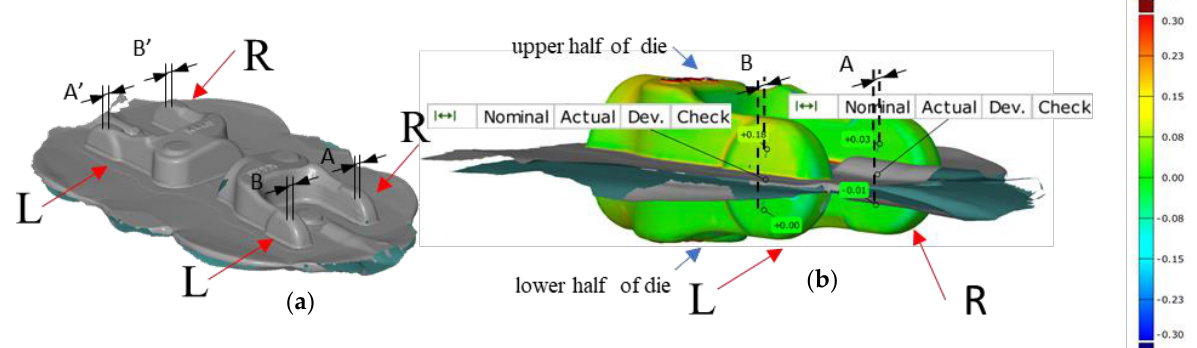
Figure 16. Exemplary results of the joggle defect analysis: ( a ) the whole forging, ( b ) half of the forging, shown on a colour map of deviations.